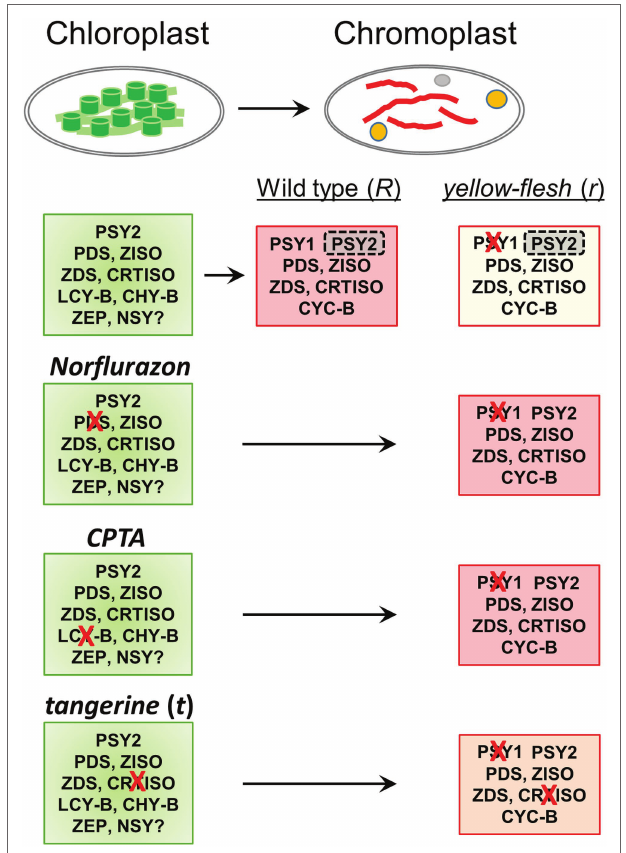
FIGURE 8 | Summary of the experimental scheme and results. Carotenoid biosynthesis enzymes in tomato chloroplasts and fruit chromoplasts are depicted in the relevant boxes (see Figure 1 for enzyme abbreviations). Phytoene is synthesized in the chloroplasts by PSY2 and in chromoplasts by PSY1. PSY1 is exclusively expressed in fruits and flowers while PSY2 is found in both chloroplasts and fruit chromoplasts. However, PSY2 is inactive in chromoplasts (shaded) and, therefore, carotenoid synthesis is blocked in the fruits of the mutant yellow flesh. Injection of norflurazon or CPTA into mature green fruit inhibits the enzymes PDS and LCY-B, respectively. Consequently, PSY2 remains active after the transition of chloroplasts to chromoplasts during fruit ripening and sustains carotenoid biosynthesis in the mutant yellow flesh . The mutation tangerine inhibits the enzyme CRTISO and causes the accumulation of tetra- cis -lycopene (“prolycopene”). This perturbation activates PSY2 in the double mutant tangerine/yellow flesh